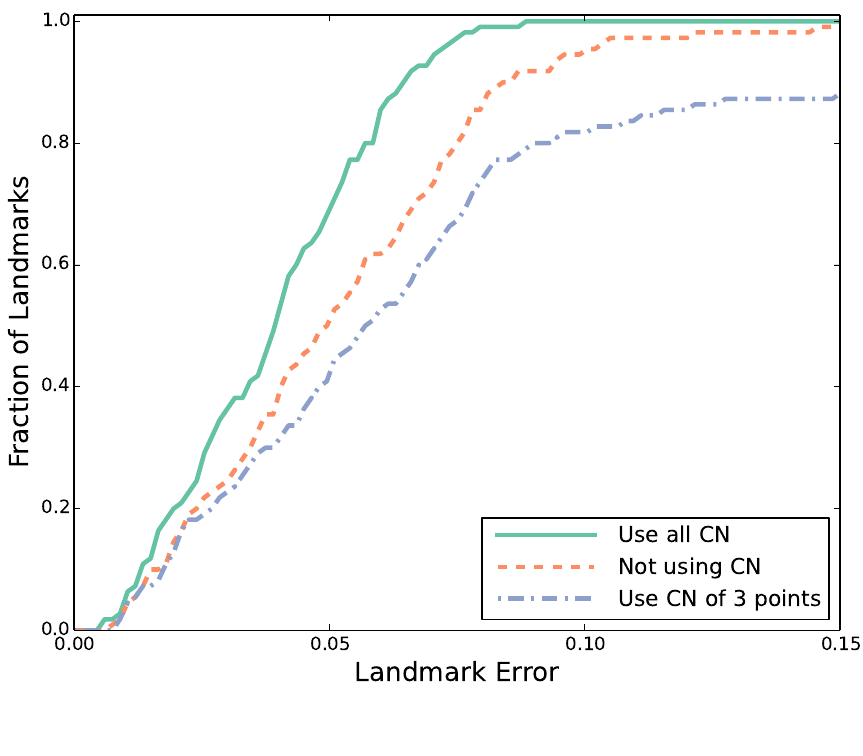
Figure 10. Cumulative error distributions of localizations with collinearity (three-point CN, red dots), all CN constraints (green solid and no shape constraints (blue dash dots). The x -axis is the normalized mean error (NME), and the y -axis indicates the percentage of images on which localization NMEs are lower than the x